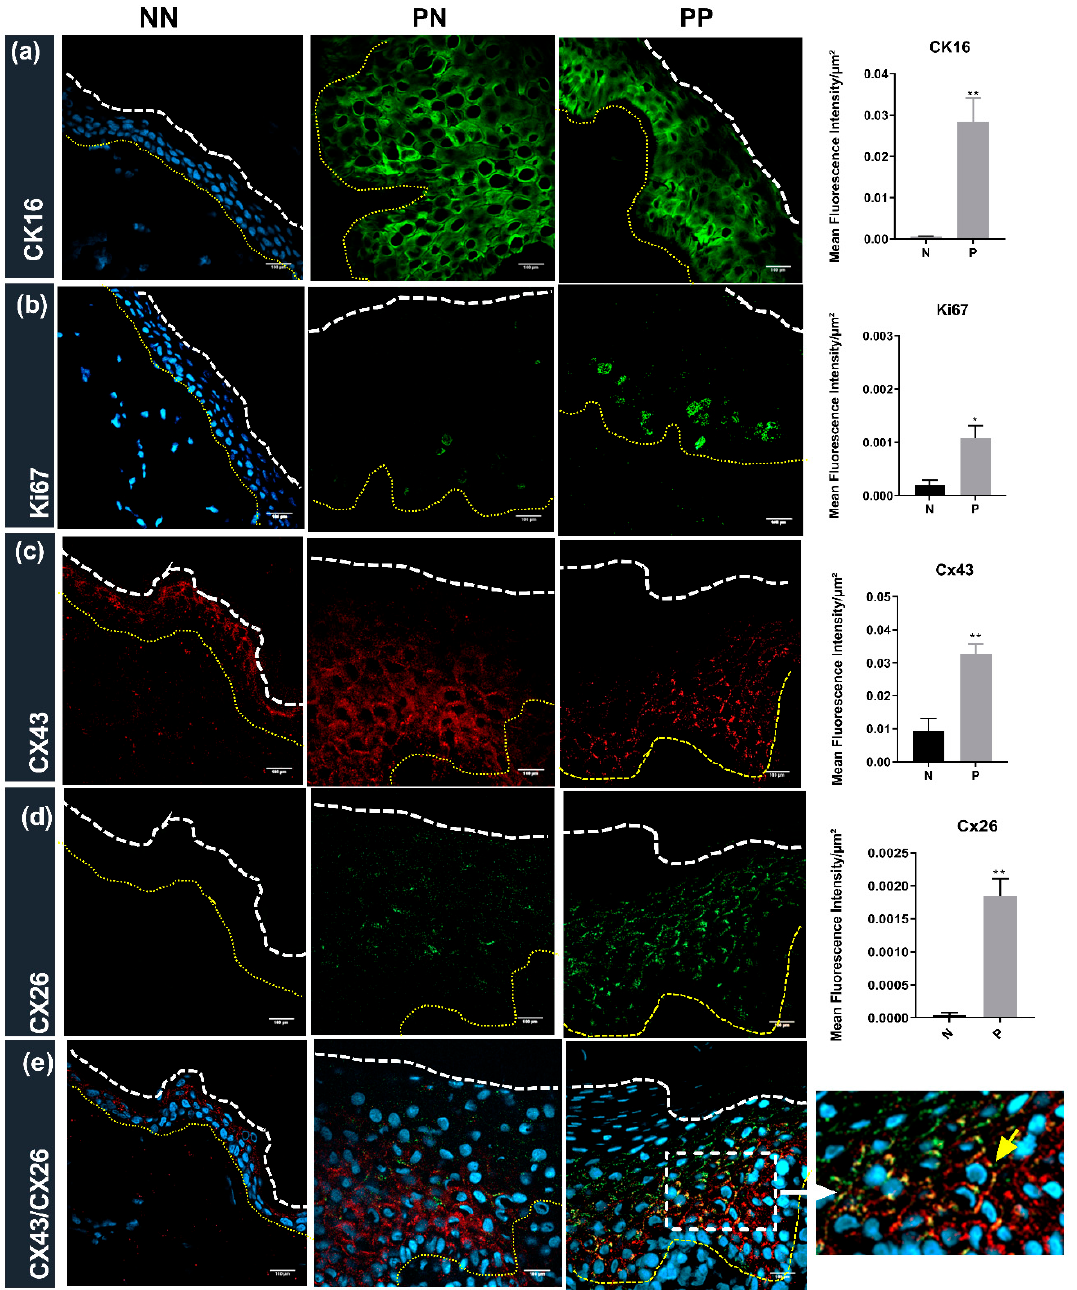
Figure 2. Immunohistochemistry of NN, PN and PP biopsies: frozen sections of biopsies were sectioned (7 um) and subject to immunohistochemical analysis. Representative images for ( a ) CK16 (green); ( b ) Ki67 (green); ( c ) CX43 (red) and ( d ) CX26 (green) are presented; ( e ) merged images of CX43, CX26 and DAPI (blue). The right-hand panel magnified insert with the yellow arrow indicating co-localisation areas. The white dotted line indicates tissue edge, and yellow dots indicate basement membrane. Bar = 100 µ m. The mean fluorescent intensity/ µ m 2 extracted from multiple images of three donors for each group is indicated in the right-hand panel for each marker. Statistical significance was calculated by two-tailed t -test * p < 0.05; ** p <